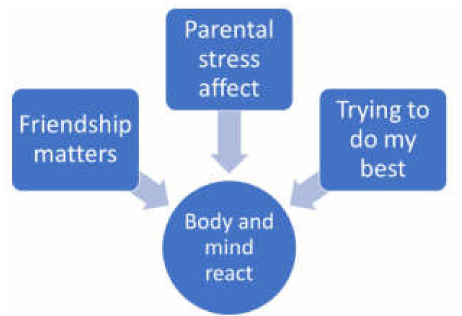
Figure 1. One theme—“Body and mind react”—and three subthemes: ( 1 ) Friendships matters, ( 2 ) Parental stress a ff ect, and ( 3 ) Trying to do my best were